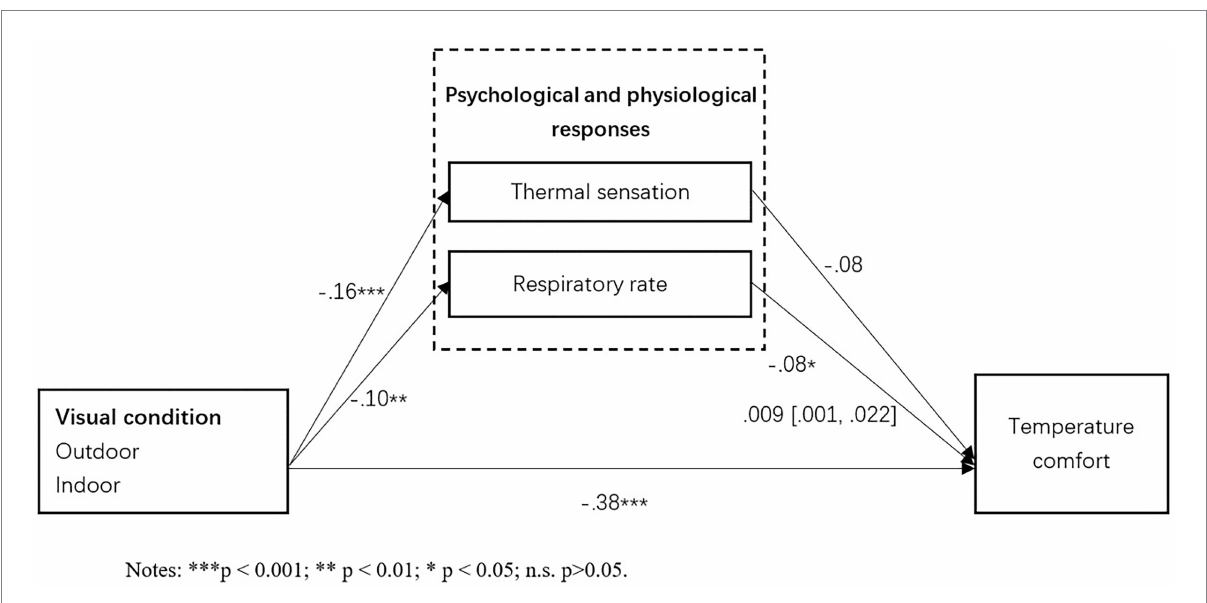
FIGURE 5 Mediating